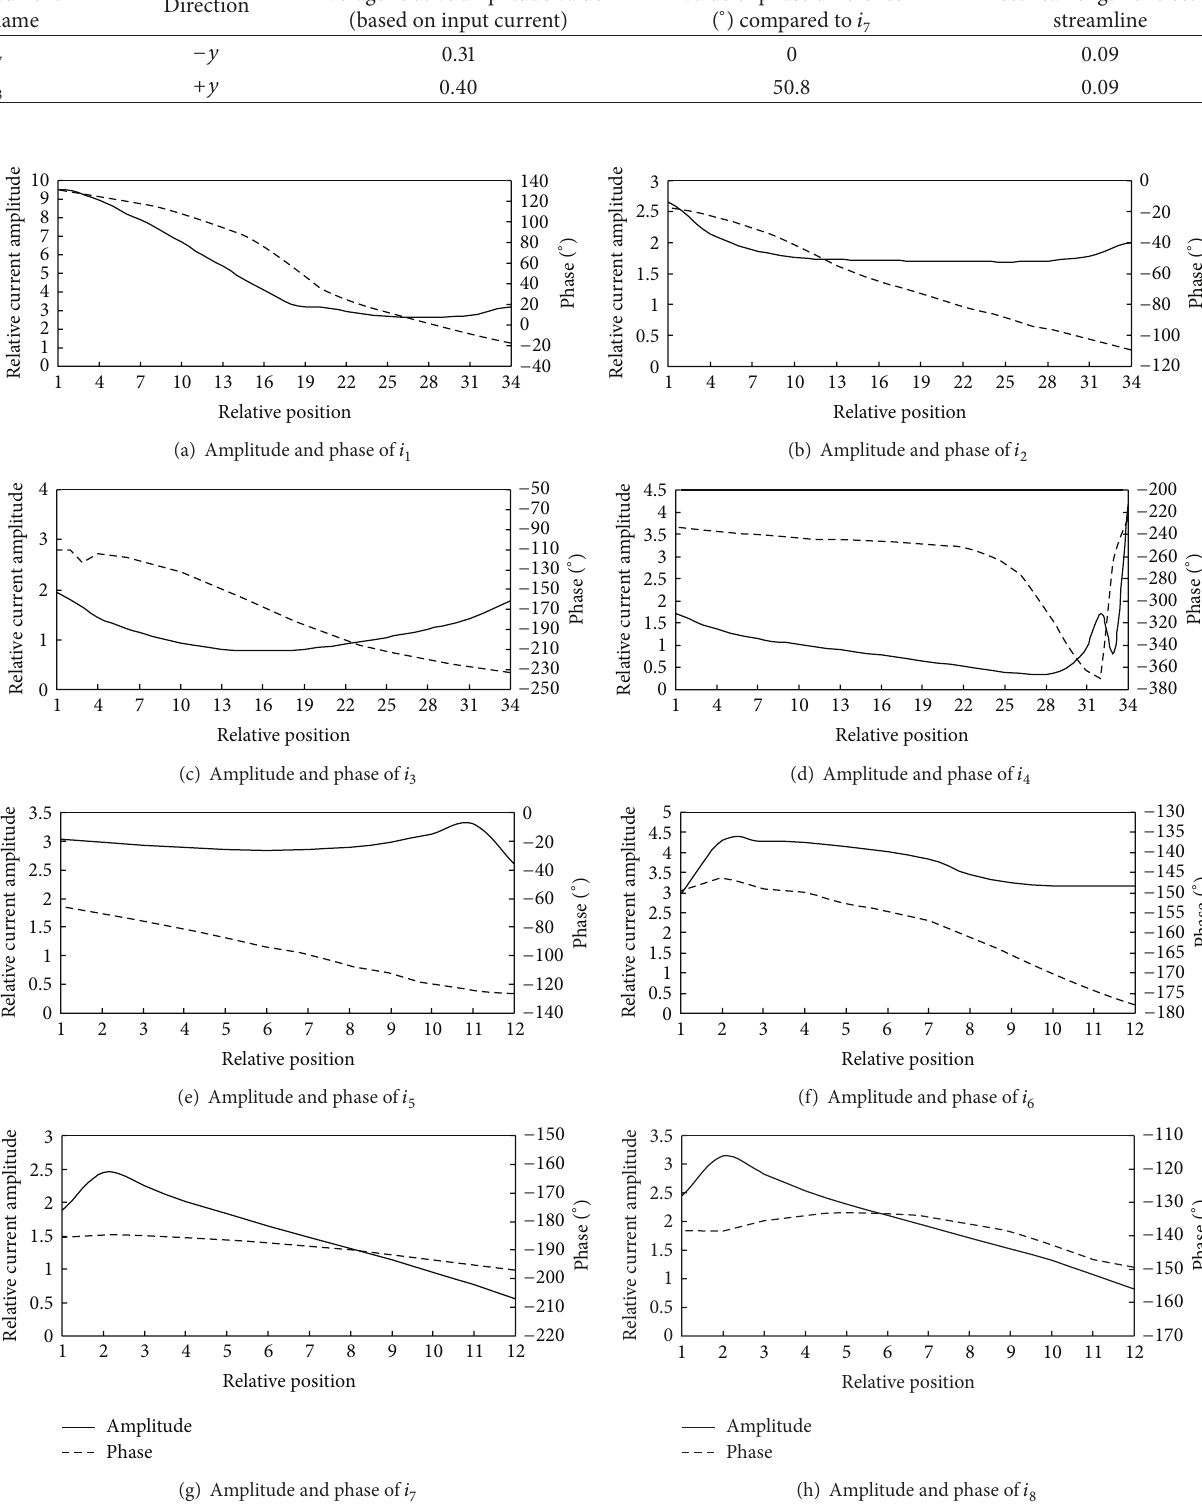
Figure 6: Amplitude and phase of each current